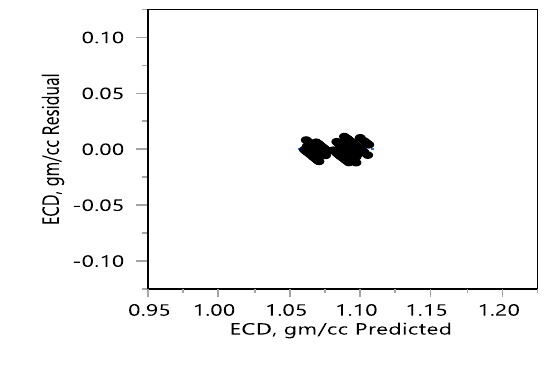
Fig. 22 Residual plot of ECD model